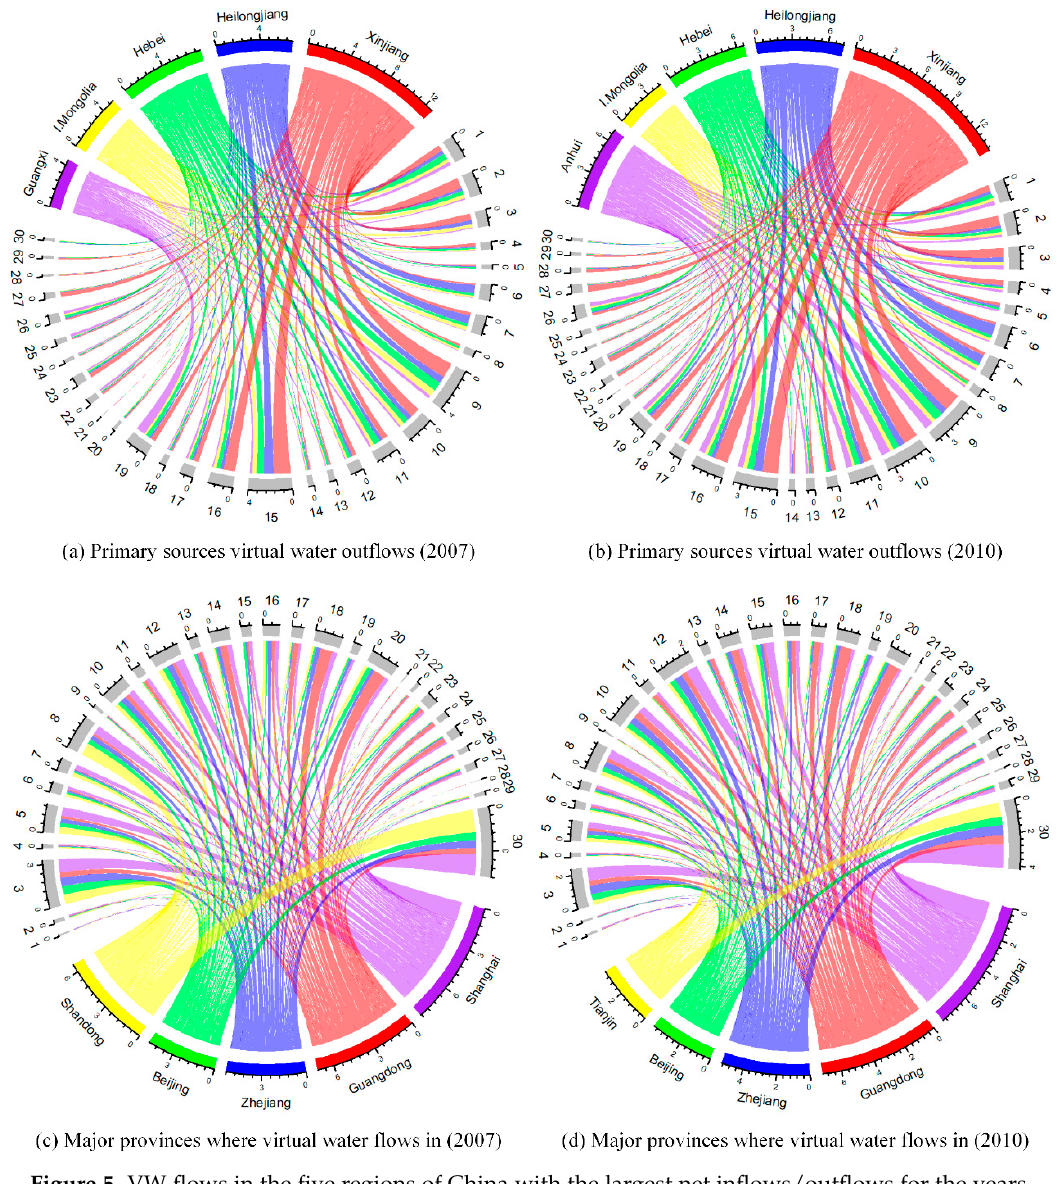
Figure 5. VW flows in the five regions of China with the largest net inflows/outflows for the years, 2007 and 2010 (100 million m 3 ). Note: 1 = Beijing, 2 = Tianjin, 3 = Hebei, 4 = Shanxi, 5 = Inner Mongolia, 6 = Liaoning, 7 = Jilin, 8 = Heilongjiang, 9 = Shanghai, 10 = Jiangsu, 11 = Zhejiang, 12 = Anhui, 13 = Fujian, 14 = Jiangxi, 15 = Shandong, 16 = Henan, 17 = Hubei, 18 = Hunan, 19 = Guangdong, 20 = Guangxi, 21 = Hainan, 22 = Chongqing, 23 = Sichuan, 24 = Guizhou, 25 = Yunnan, 26 = Shaanxi, 27 = Gansu, 28 = Qinghai, 29 = Ningxia and 30 = Xinjiang.